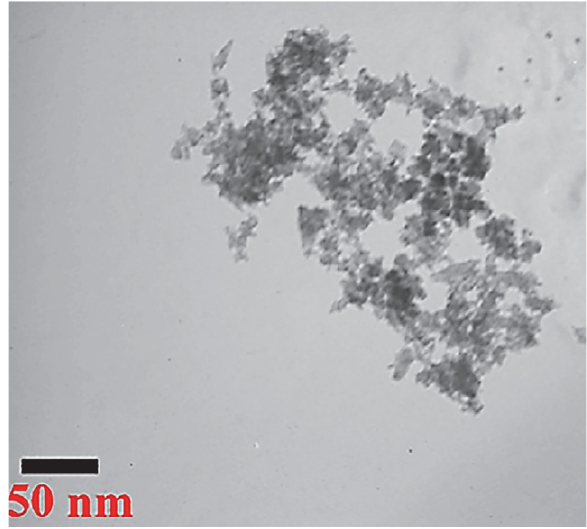
Figure 2. TEM image for MnFe 2 O 4